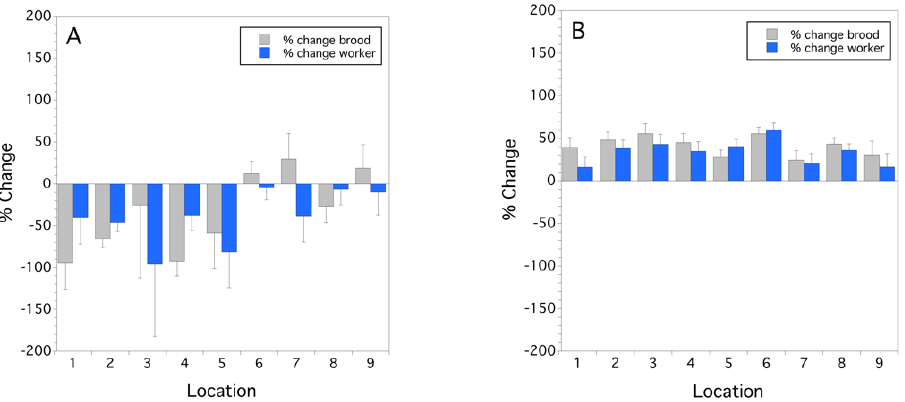
Figure 1. Mean colony population rate of change from initial colony strength over the bloom period per location for sealed brood and workers for 2014 ( A ) and 2015 ( B ); zero on the y-axis represents no change in sealed brood or worker colony strength during bloom. Error bars are standard errors of the mean ( n = 3 and n = 5 for 2014 and 2015, respectively).